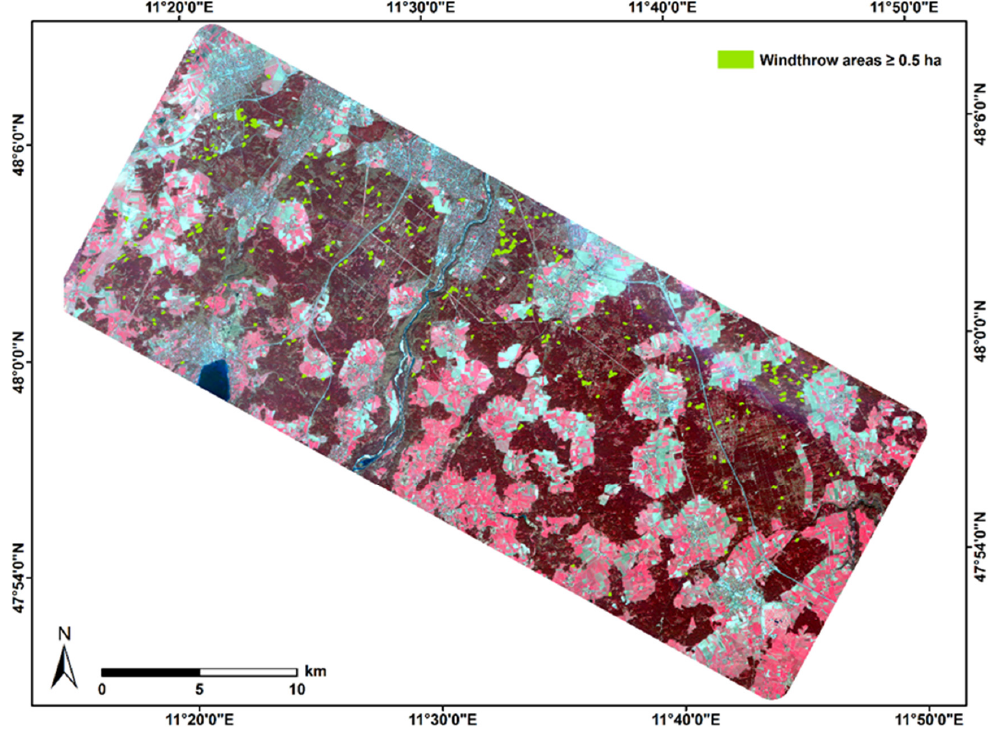
Figure 10. Occurrence of windthrow areas ≥ 0.5 ha (green areas) in the Munich South study area. As background is the false color composite (band combination: near infrared—red—green) post-storm RapidEye scene depicted.